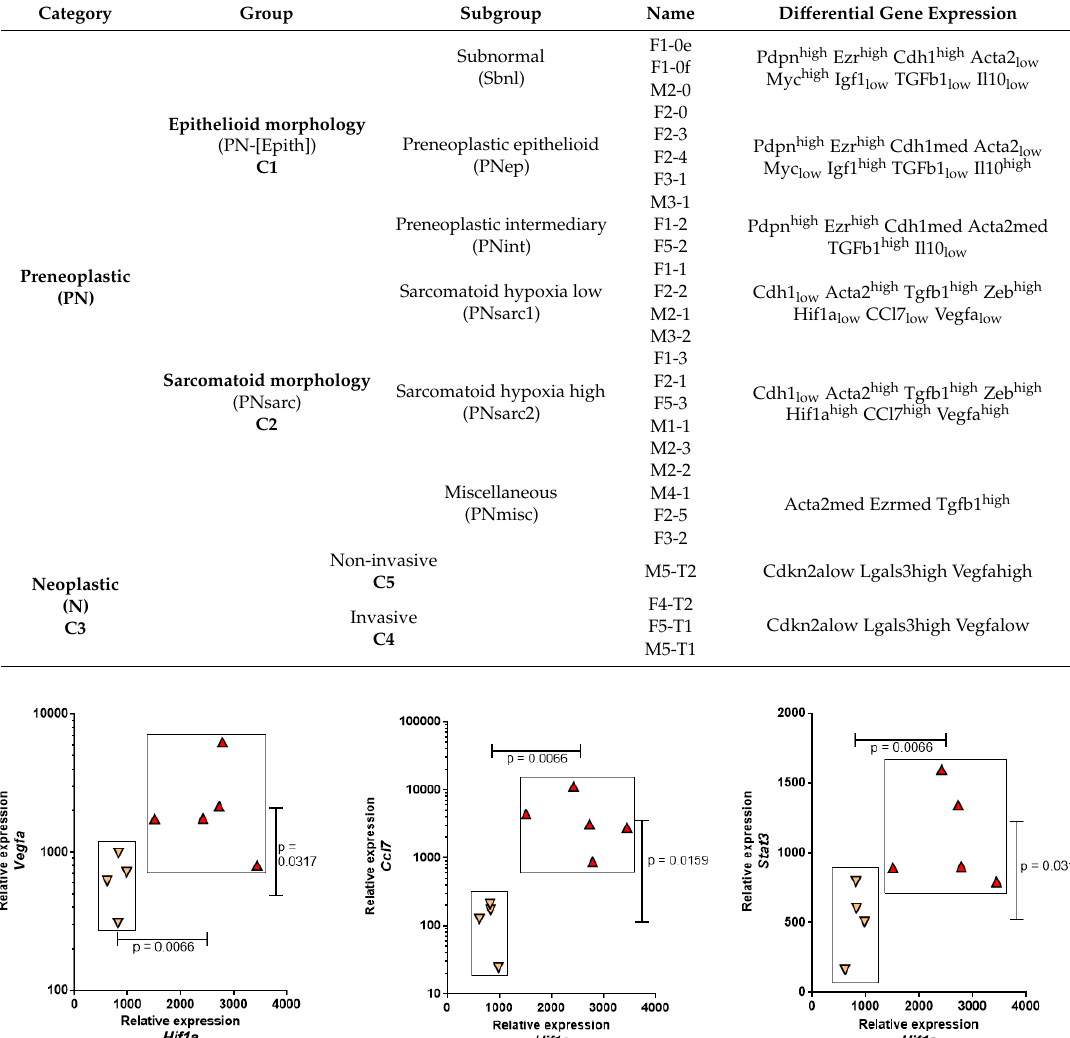
Figure 2. Di ff erential expression of Hif1a within preneoplastic cell lines with sarcomatoid morphology (PNsarc, C2). Expression of Hif1a in the two subgroups (PNsarc1 in yellow, PNsarc2 in red triangles) of rat preneoplastic mesothelial cell lines with sarcomatoid morphology and their relationships with Vegfa , Ccl7 , and Stat3